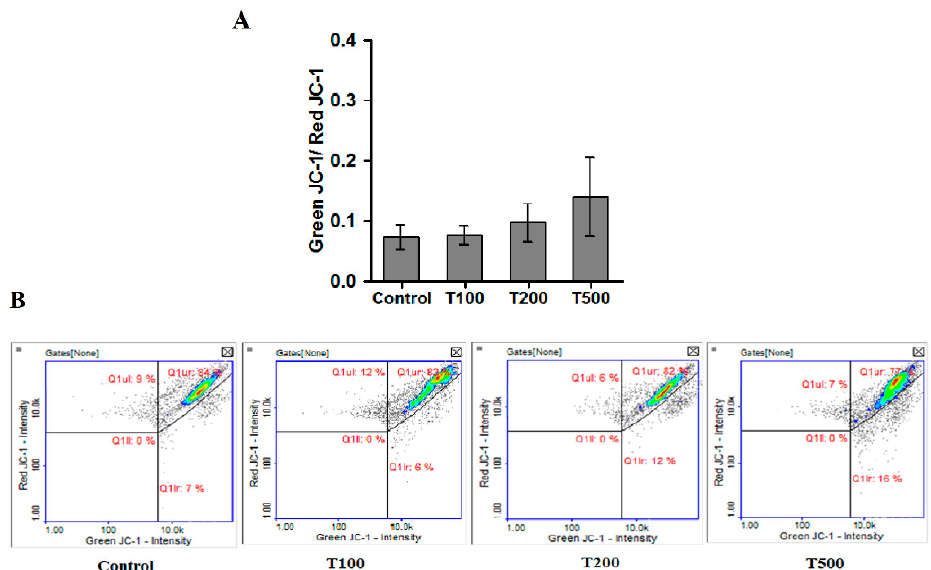
Figure 8. ( A ) Mitochondrial membrane potential in RPMI 8226 cells treated with teriflunomide (T) (100–500 µM) or DMSO as vehicle in control cultures based on image cytometry analysis. Scatter plots show the Green JC-1 intensity versus the intensity of Red JC-1. Values were presented as mean ± SD derived from three independent experiments. ( B ) The results show one representative experiment of three independently performed.